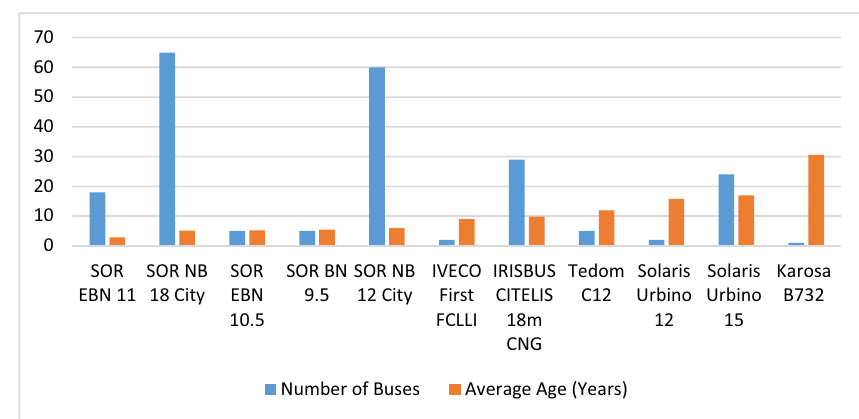
Figure 1: The fl eet structure [ 20 ]